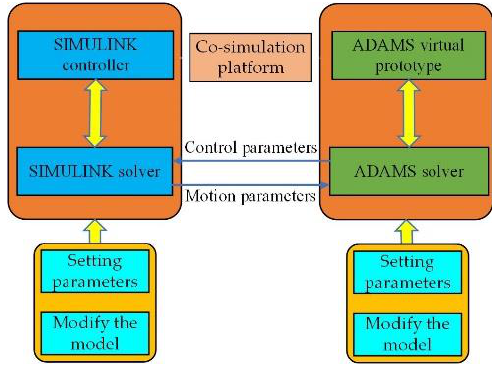
Figure 5. The scheme of cosimulation.